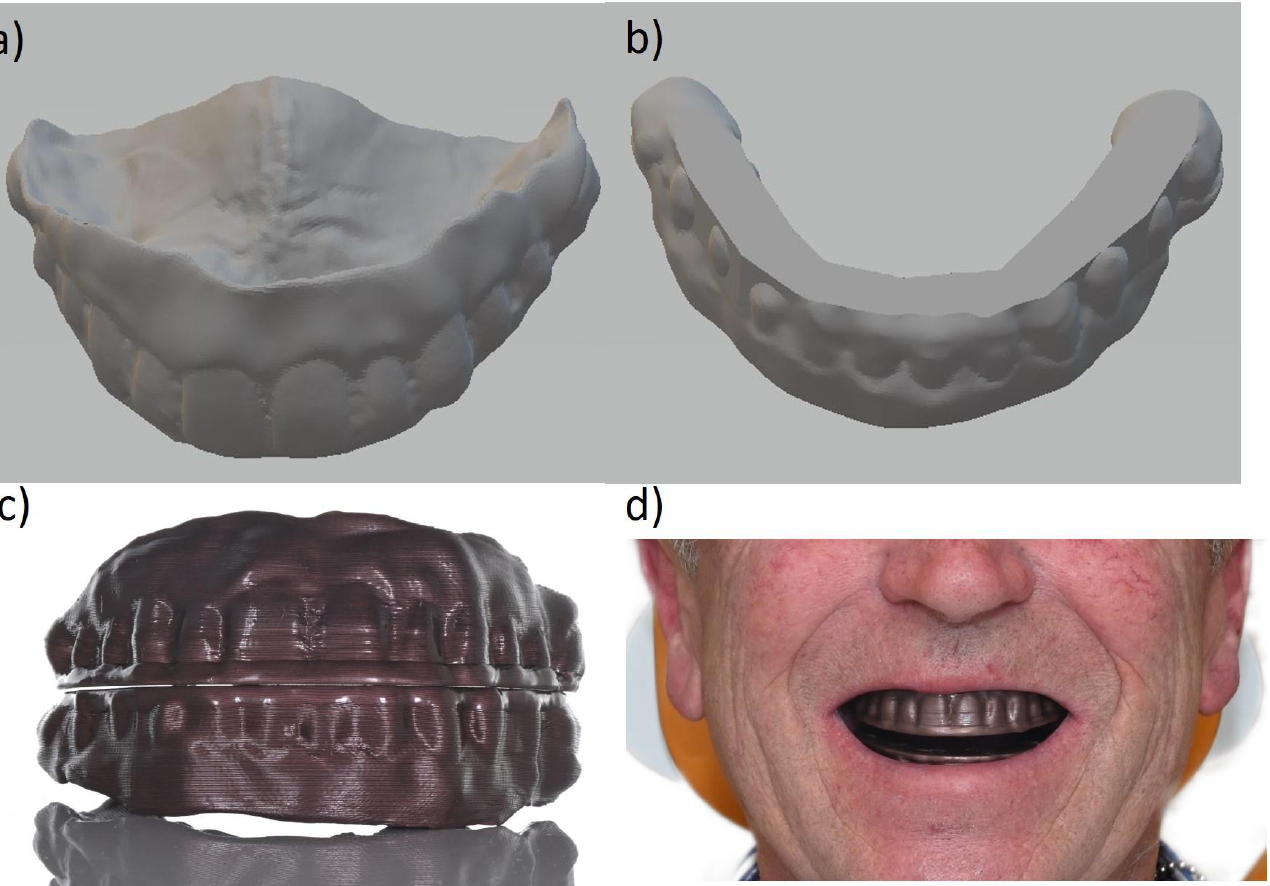
Figure 3. ( a ) STL model of the upper jaw with a flat contact surface, ( b ) STL model of the lower jaw with a flat contact surface, ( c ) bite plates manufactured by FFF ( d ) fitting of the bite plates.